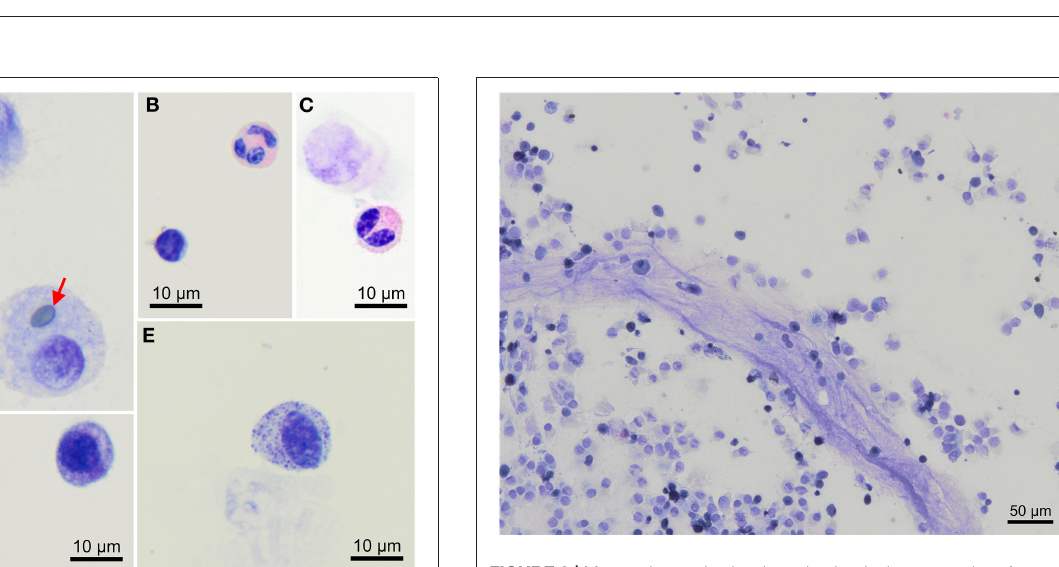
FIGURE 1 | Overview of cells found in a bronchoalveolar lavage sample from two healthy cynomolgus macaques. (A) macaque #1, (B) macaque #2. Alveolar macrophages (M ϕ ) predominate, followed by lymphocytes (L). Neutrophil (N) and occasional ciliated columnar epithelial cells (E) are also present. Modified Giemsa. X50 objective. Oil immersion.